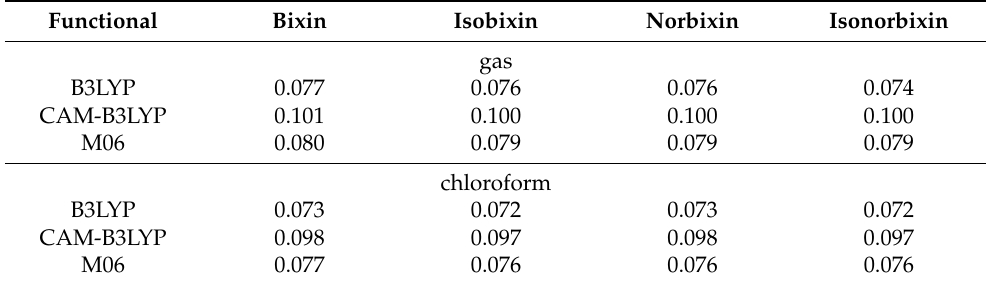
Figure 2. Optimized geometries of the bixin, isobixin, norbixin, and isonorbixin in chloroform solution. These geometries were obtained within the framework of the CAM-B3LYP/6-31+G(d,p) level of theory. Table 1. Total BLA values (Å) in the gas phase ( (cid:101) = 1.00) and chloroform ( (cid:101) = 4.71) solution, which were determined by employing the 6-31+G(d,p) basis